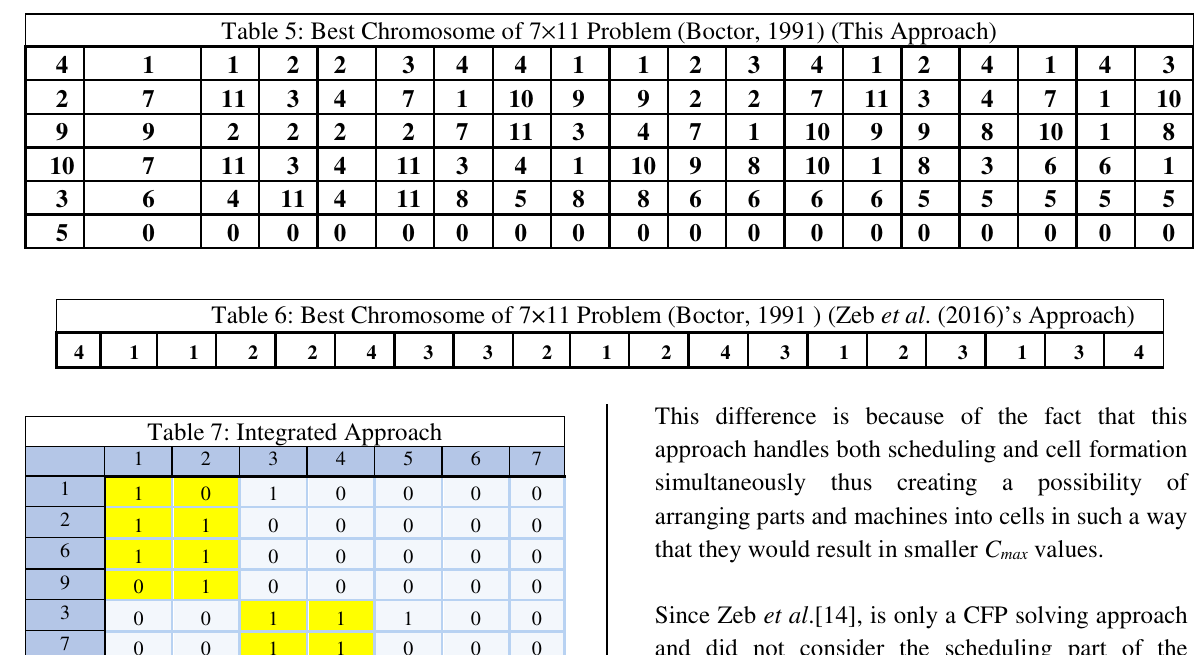
Table 5: Best Chromosome of 7 × 11 Problem (Boctor, 1991) (This Approach)